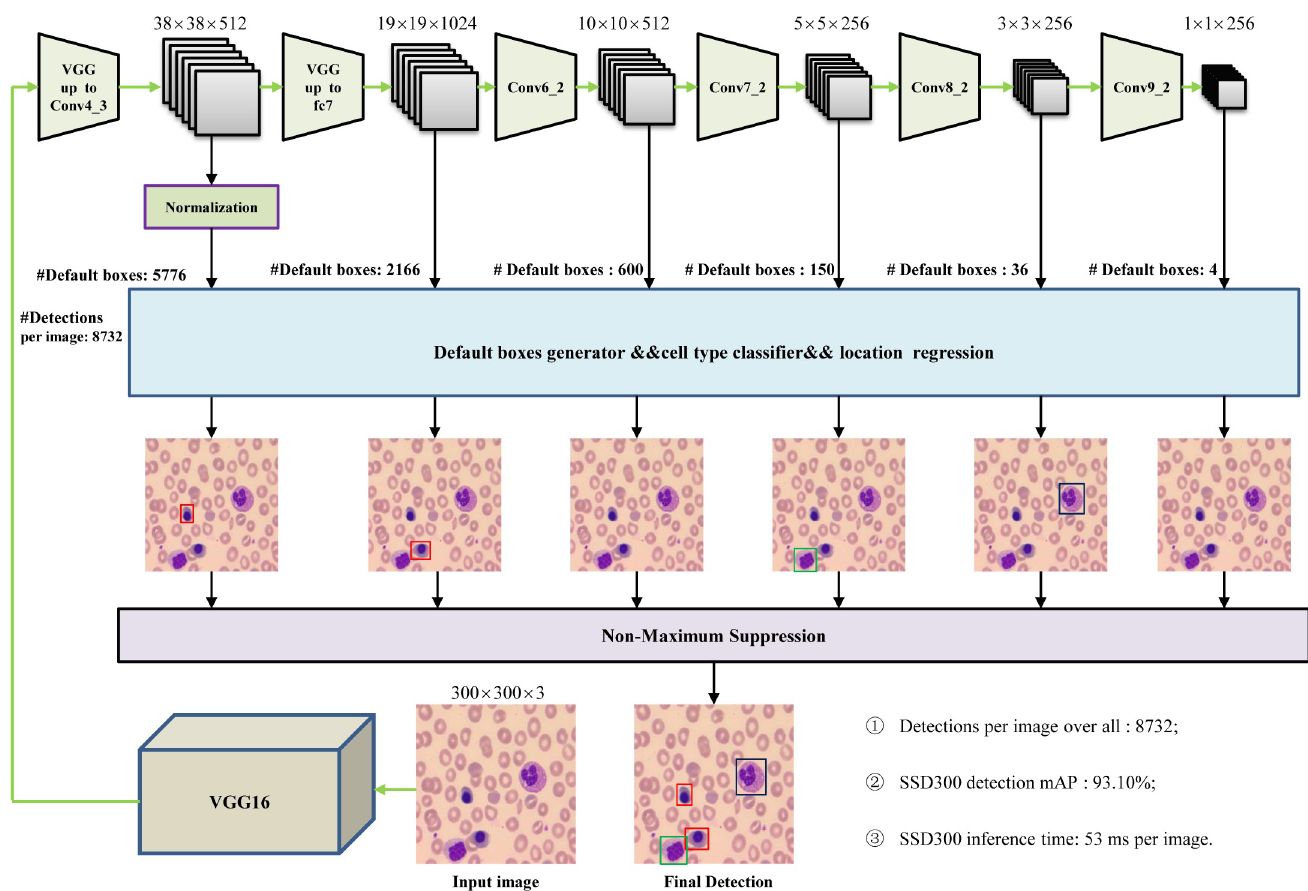
Fig 4. SSD architecture. To multi-scale feature maps for detection, several feature layers (Conv6_2, Conv7_2, Conv8_2 and Conv9_2) were added to the end of base network (VGG16), where the larger size feature maps, such as Conv4_3, were used to detect small size leukocytes while the smaller size feature map to detect the large